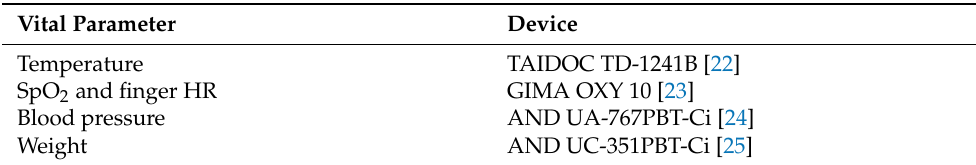
Table 1. Bluetooth sensors provided in the home kit of